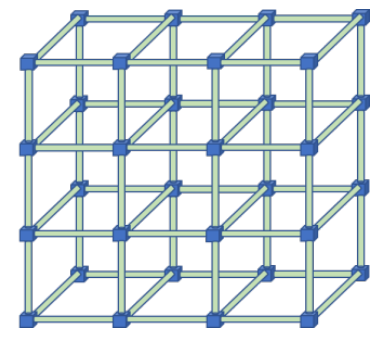
Figure 5. Schematic representation of the MOF’s structure.